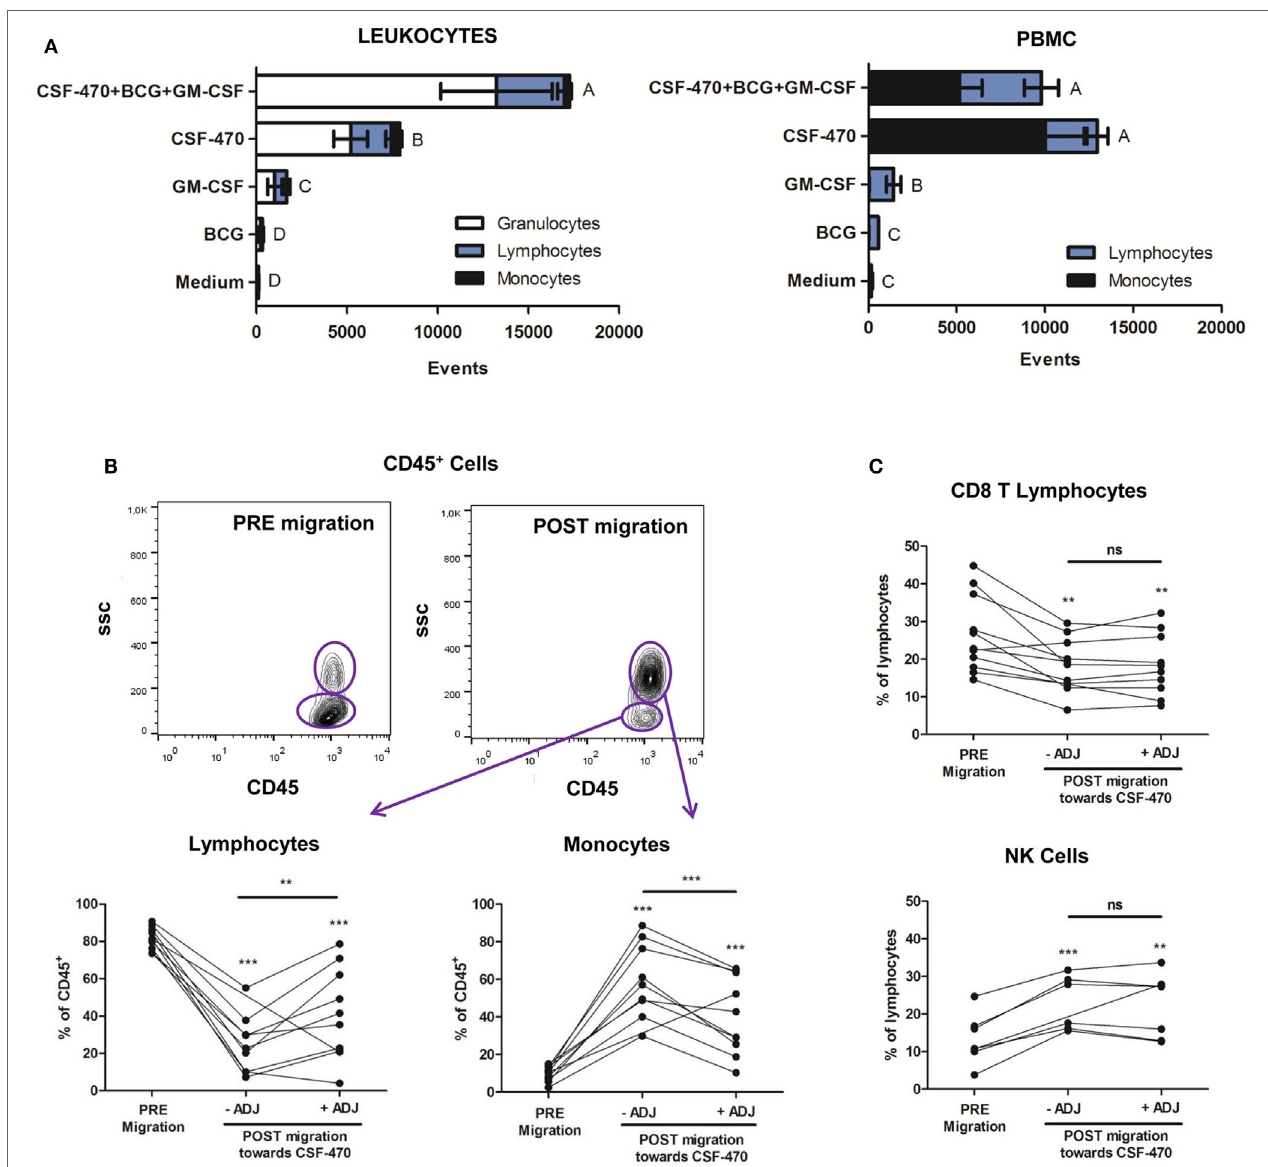
FigUre 1 | Leukocyte and mononuclear cell migration toward CSF-470 vaccine. (a) Left panel: Leukocyte migration showed as event counts toward each component: adjuvants bacillus Calmette–Guerin and granulocyte macrophage colony-stimulating factor (ADJ), CSF-470 vaccine or vaccine plus adjuvants, n = 11. (a) Right panel: Mononuclear cell migration is shown as event counts toward each component: individual adjuvants, CSF-470 vaccine or vaccine plus adjuvants, n = 10. Bars with different letters are statistically different ( p < 0.05). (B) Frequency of monocytes and lymphocytes in PRE- and POST-migrated CD45 + population toward the vaccine with or without adjuvants (paired T -test; * p < 0.01, ** p < 0.001; *** p < 0.0001). (c) Frequency of CD3 + CD8 + T cells and natural killer cells in PRE- and POST-migrated lymphocyte population toward CSF-470 vaccine with or without adjuvants (paired T -test; * p < 0.01, ** p < 0.001; *** p < 0.0001), n =